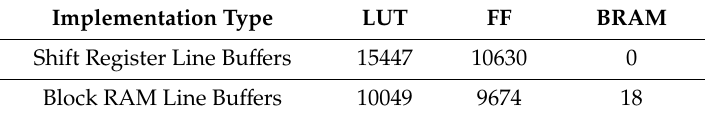
Table 1. SYBA resource utilization for the FAST detector and SYBA descriptor.